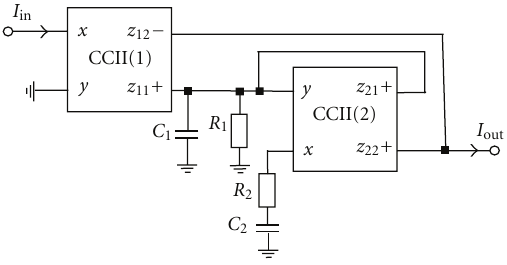
Figure 3: The current-mode second-order filter.